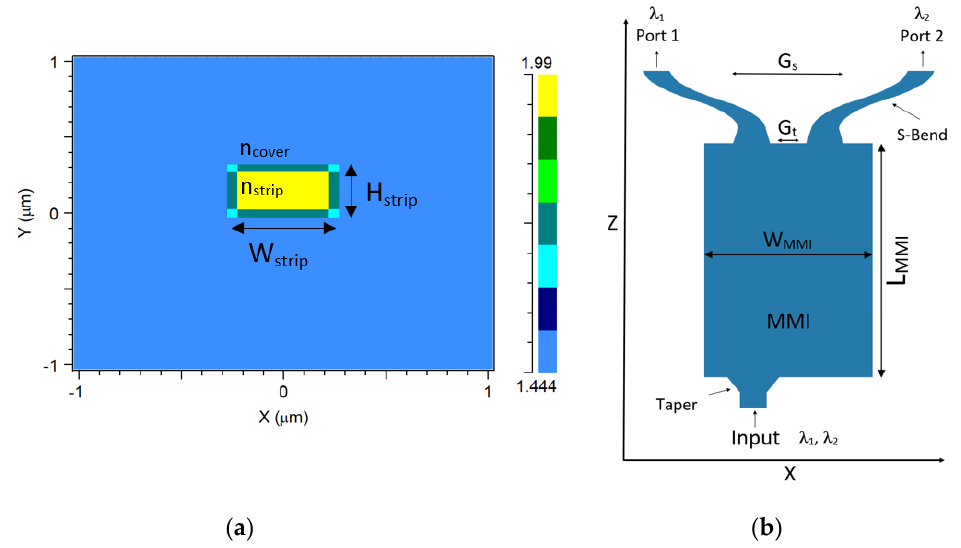
Figure 1. An illustration of the two-channel MMI demultiplexer. ( a ) The refractive index profile at the XY plane; ( b ) The device profile at the XZ plane.